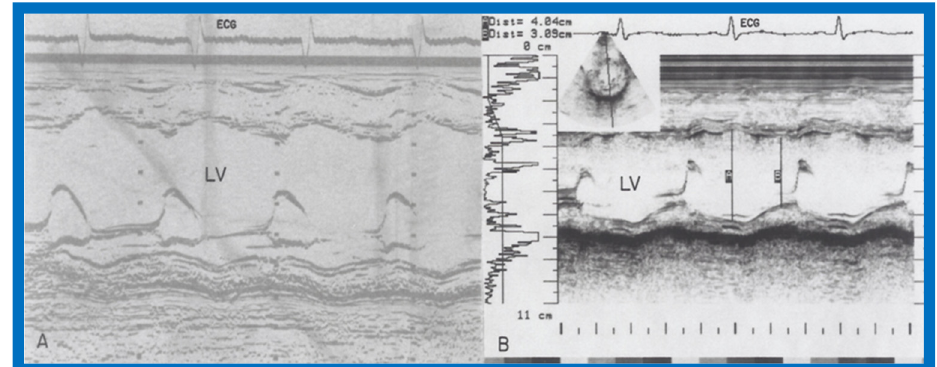
Figure 40. Selected M ‐ mode recording from the parasternal short axis view of the left ventricle (LV) prior to ( A ) and following ( B ) hydrazine therapy. Note the significant improvement in the LV size and function.